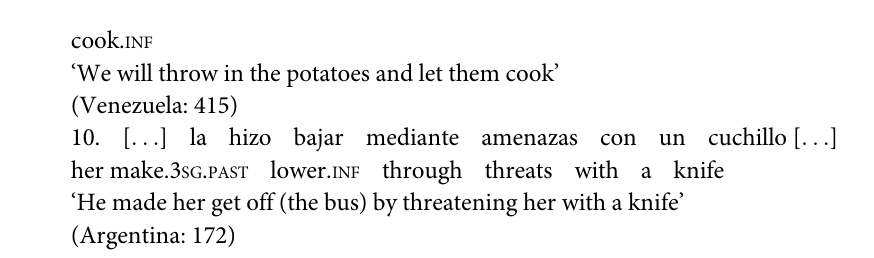
Fig 2. Marginal effects of Model-1. The y-axis represents the posterior predicted probability of the dative clitic.